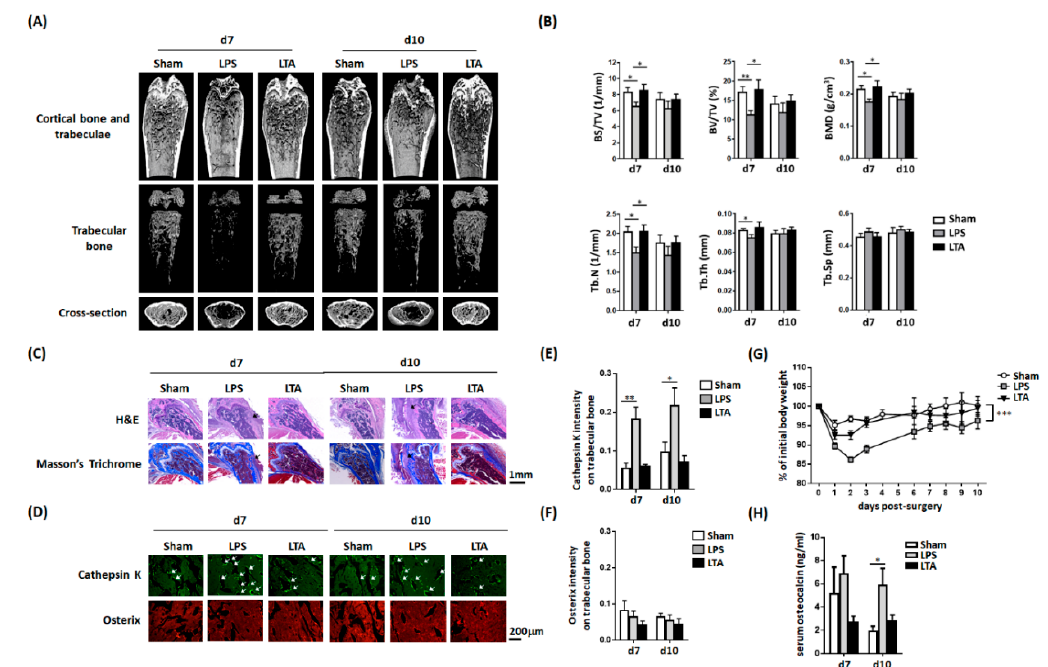
Figure 2. Lipopolysaccharide and lipoteichoic acid exert distinct e ff ects on the bone mineral density, bone morphology, cathepsin K expression, and serum osteocalcin concentrations in mice. ( A ) Mice were subjected to an intrafemoral injection of LPS, LTA, or PBS (vehicle). The results of micro-CT revealed that LPS, but not LTA, decreased the number of bone trabeculae. ( B ) Quantitative results of micro-CT analysis in mice treated with PBS ( n = 7), LPS ( n = 5), or LTA ( n = 5). LPS, but not LTA, was found to reduce morphometric bone indices. ( C ) Hematoxylin / eosin and Masson’s trichrome staining revealed a dense bone morphology in PBS-treated mice, whereas LPS injection resulted in bone loosening (black arrow)—a finding which was not observed in LTA-treated mice. ( D ) Immunofluorescence was used to detect cathepsin K (an osteoclast marker) and osterix (an osteoblast marker). LPS, but not LTA, increased the cathepsin K fluorescence intensity, whereas osterix expression was una ff ected by either treatment. Quantitative expression of cathepsin K ( E ) and osterix ( F ) in mice treated with PBS, LPS, and LTA. ( G ) Body weight was measured daily in mice treated with PBS, LPS, and LTA and all results were normalized to the initial weight of each mouse. ( H ) Serum osteocalcin levels were measured by ELISA at indicated time points after injection. Data are presented as means ± standard errors of the mean. Analyses were conducted with two-way ANOVA, followed by Bonferroni’s post-hoc test. * p <